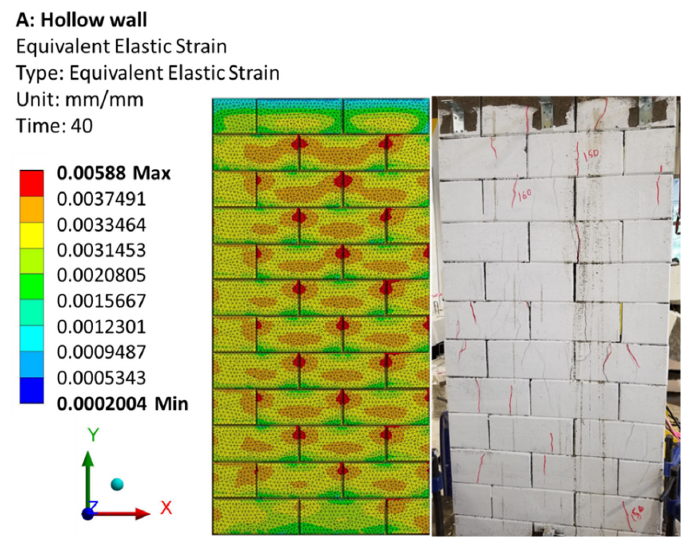
Figure 12. Failure mode (equivalent elastic strain) of hollow wall experimentally and FE model.